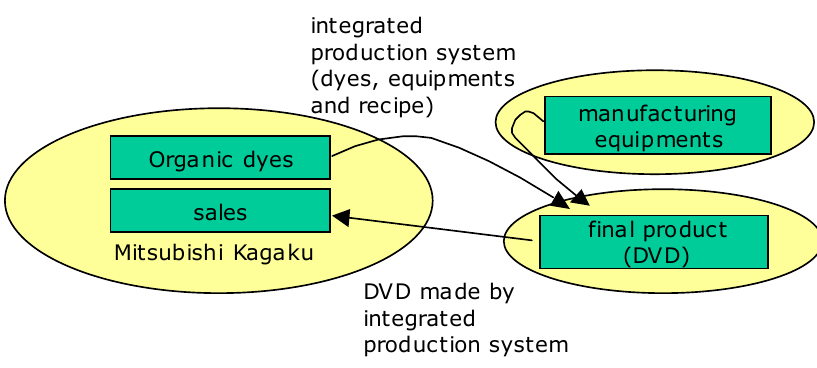
Figure 14. Business model of Mitsubishi